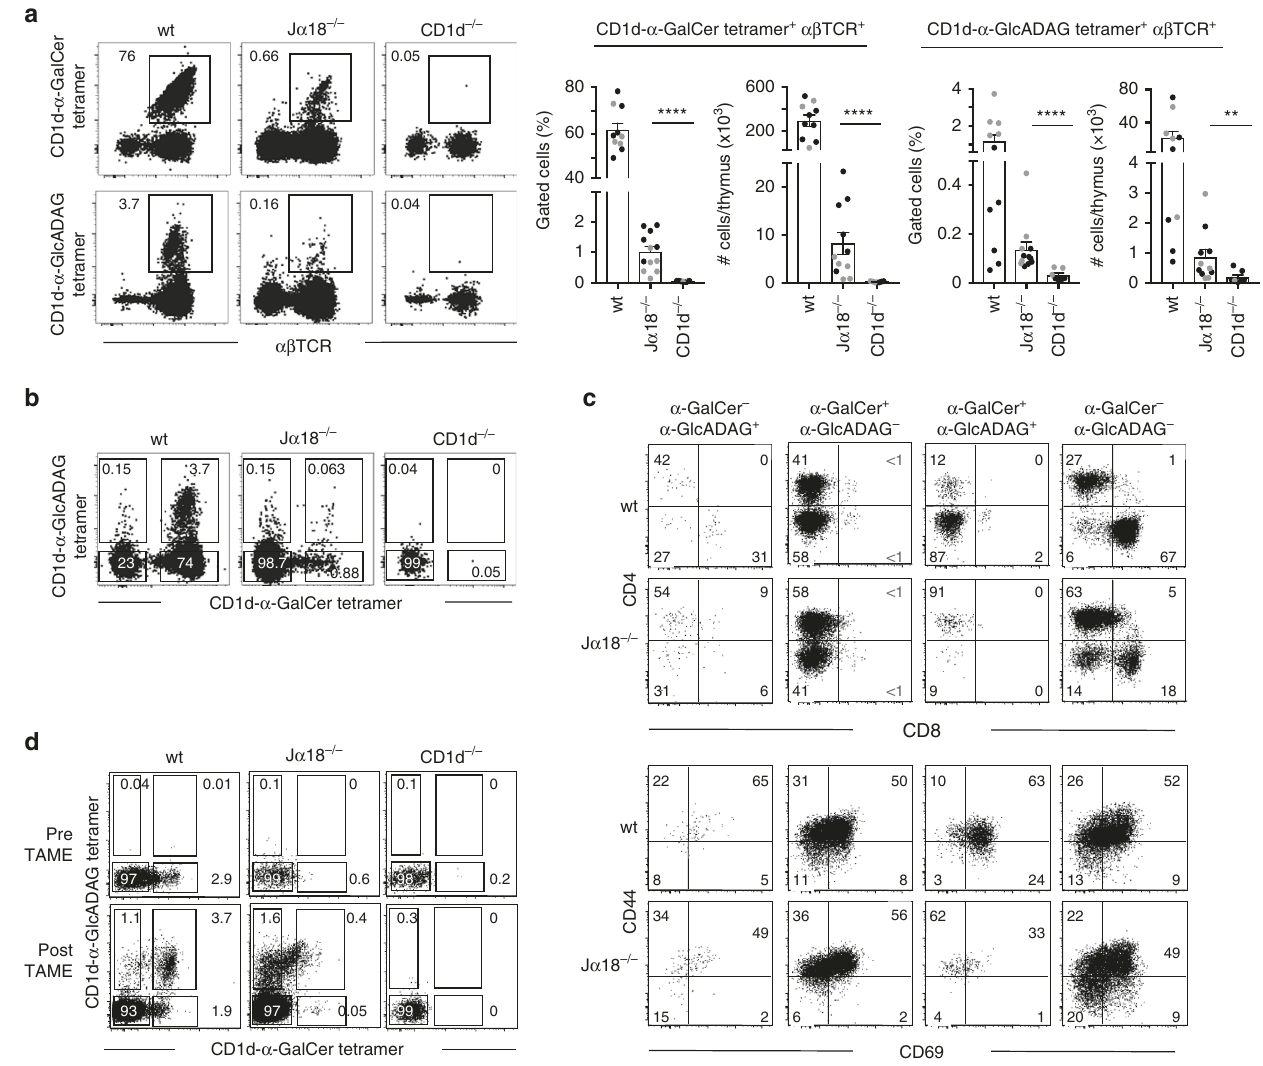
Fig. 1 Identi fi cation of CD1d – α -GlcADAG tetramer + NKT cells in mice. Flow cytometry analysis of anti-CD24-depleted thymocytes from BALB/c wt, J α 18 − / − or CD1d − / − mice a . On the left, representative plots showing αβ TCR versus CD1d – α -GalCer tetramer (top) or CD1d – α -GlcADAG tetramer staining (bottom) on gated 7AAD − B220 − CD11c − CD11b − thymocytes. Numbers next to outlined areas indicate percent cells in each gated population. Graphs on the right show the frequency and total cell numbers per whole thymus, of the population identi fi ed by the gate in each plot. Values are representative of a total of n = 7 individual experiments where in 5 (out of 7) experiments each black dot represents a pool of fi ve mice (Exps. #1 and #2) or three mice (Exps. #3 – 5) thymi per group and in 2 (out of 7) experiments the grey dots represent individual thymi. ** p = 0.0079, **** p <0.0001 determined by the two tailed Mann – Whitney U